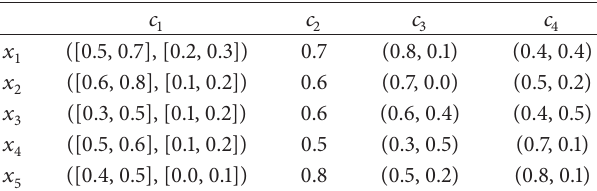
Table 3: Evaluation information at 𝑡 3 time episode.